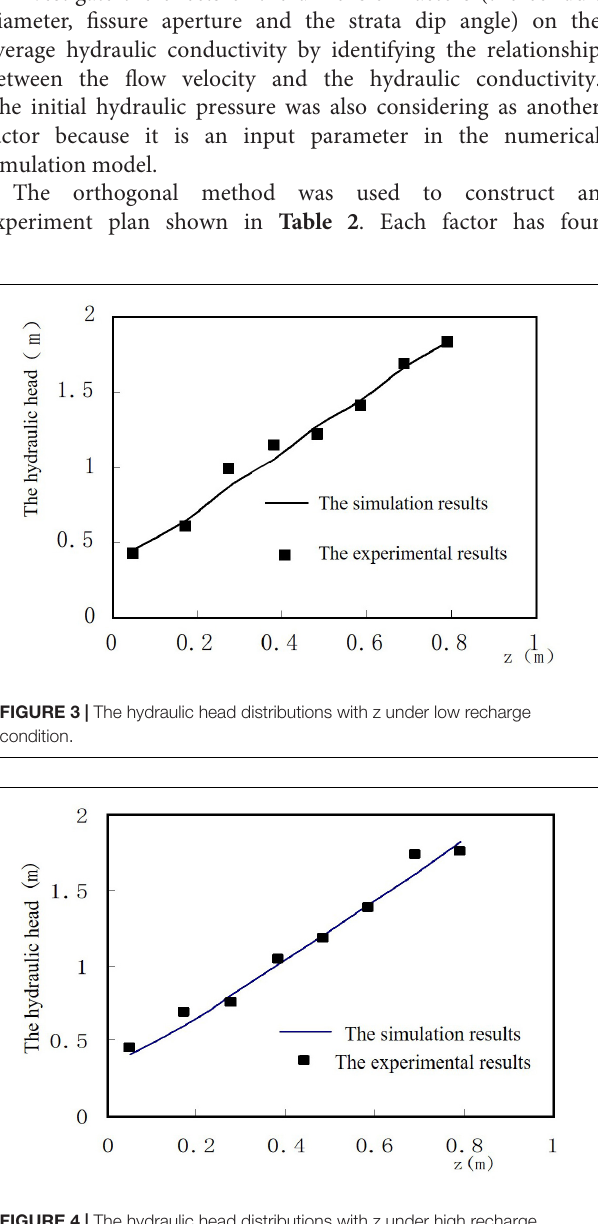
FIGURE 4 | The hydraulic head distributions with z under high recharge